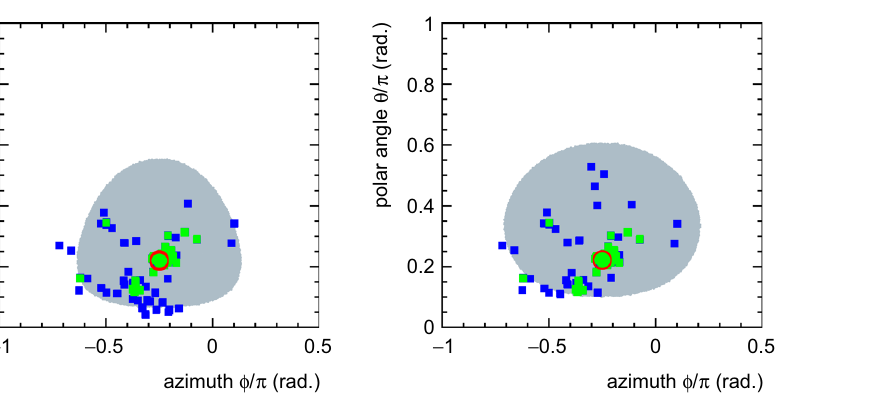
Fig. 10 The average contribution to the jet energy (left plot) and jet mass (right plot) of 200 GeV of forward-peaked background